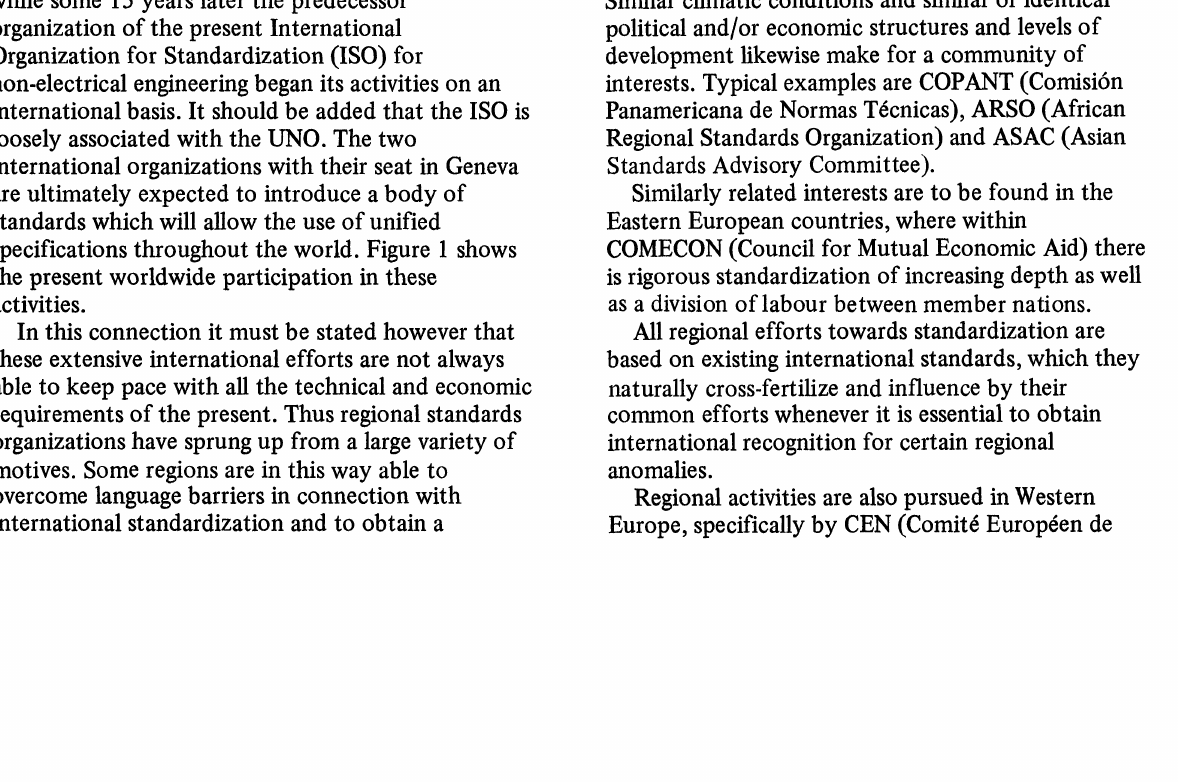
ISO ISO and IEC ISO, IEC, CEN and CENELEC FIGURE Member countries of CEN, CENELEC, ISO and